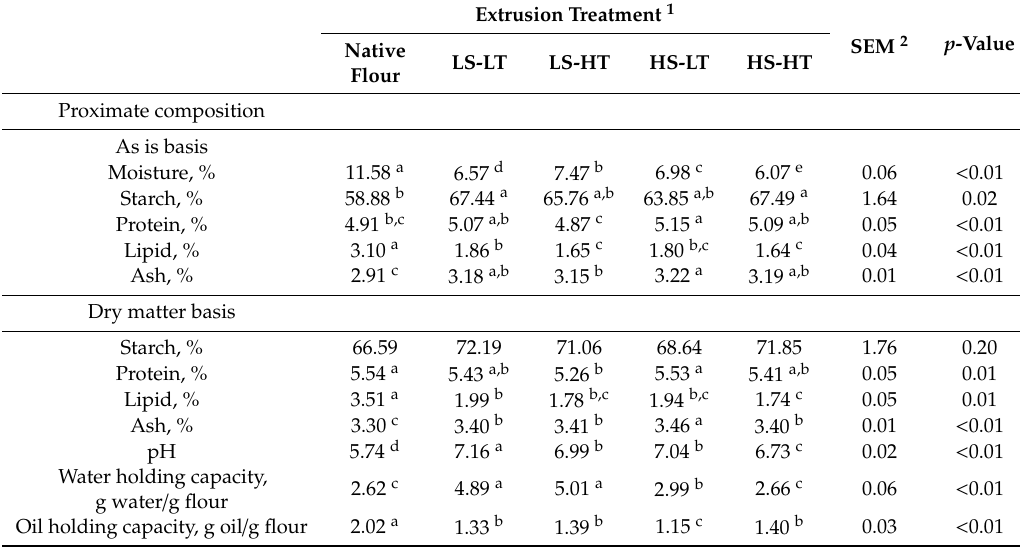
Table 2. E ff ects of the modification of breadfruit flour with extrusion on flour proximate composition, pH, water holding capacity, and oil holding